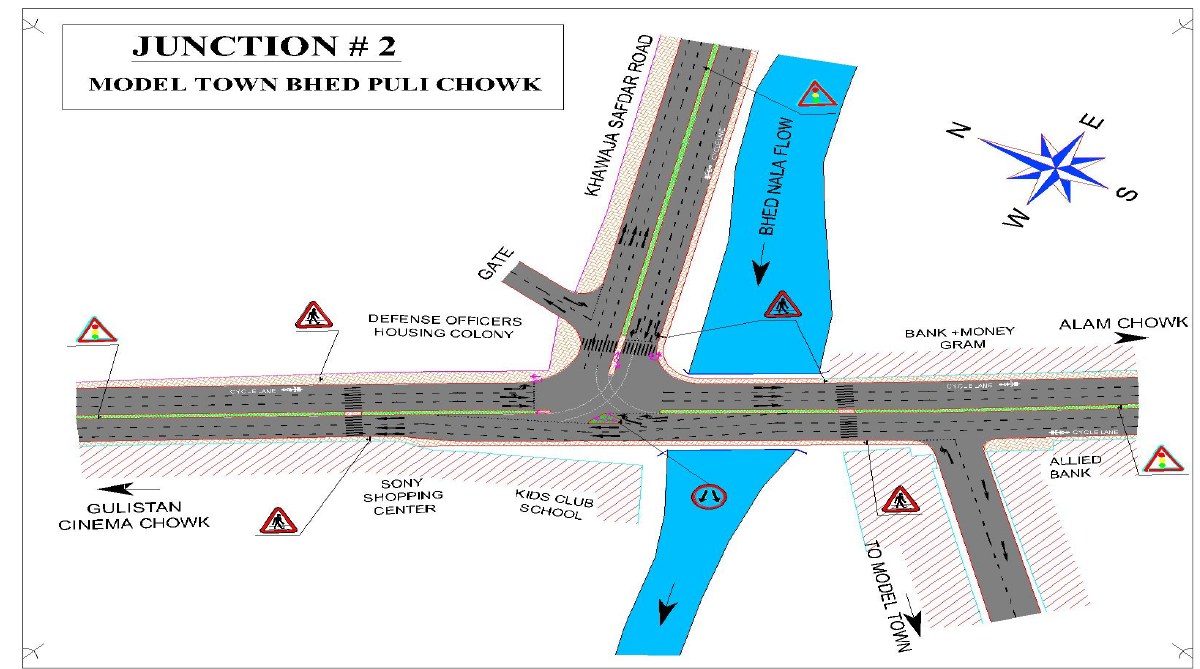
Fig. 9: Modified Design of Model Town Intersection